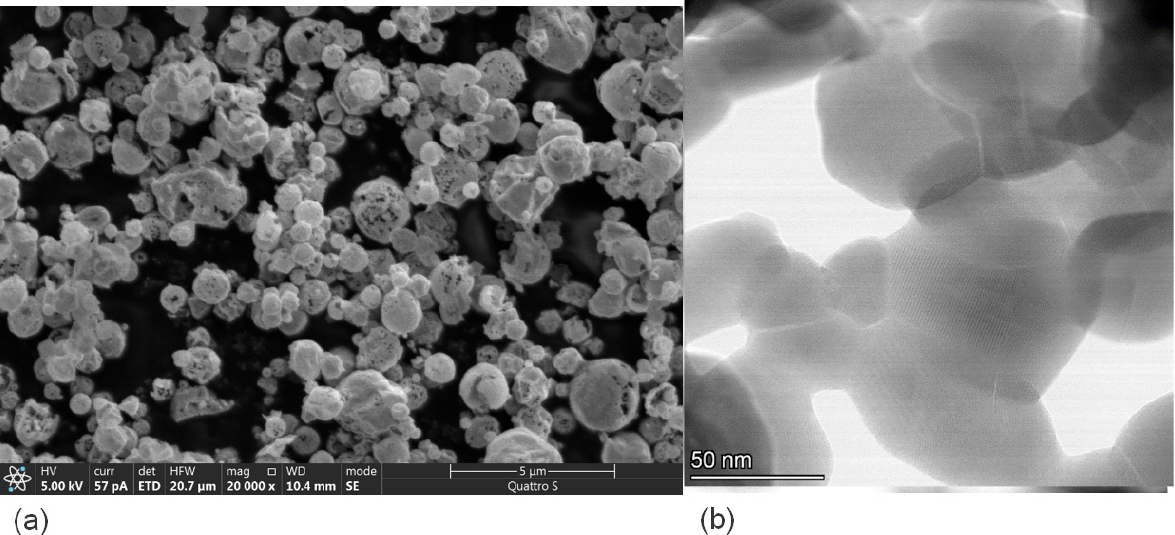
Figure 3. ( a ) SEM and ( b ) HAADF-STEM images of LSNF sample prepared using the USP method.